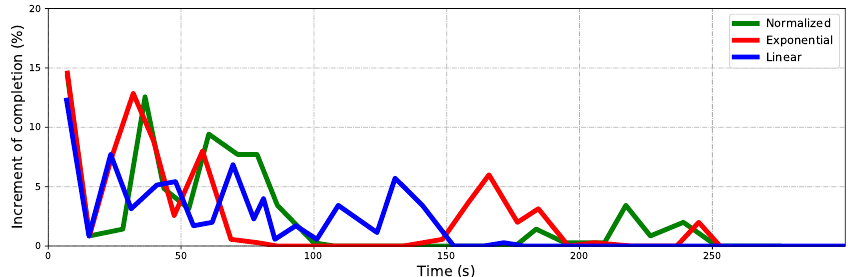
Figure 8. The increment of completion percent for three algorithms in the indoor scenario. The proposed Normalized method is more efficient because it is not easy to get stuck in the local minimum, the Exponential always focuses on the local area and fails to detect tasks far away, and the Linear prefers a breadth-first search and may fail a local reverse. When exploring, some voxels are unknown and counted in a utility calculation but cannot be scanned as occlusion, imperfect perception of the depth sensor, or failure of map update. Especially, the occlusion will cause the local reverse, the voxels that cannot be updated immediately make some corresponding viewpoints maintain valuable for information